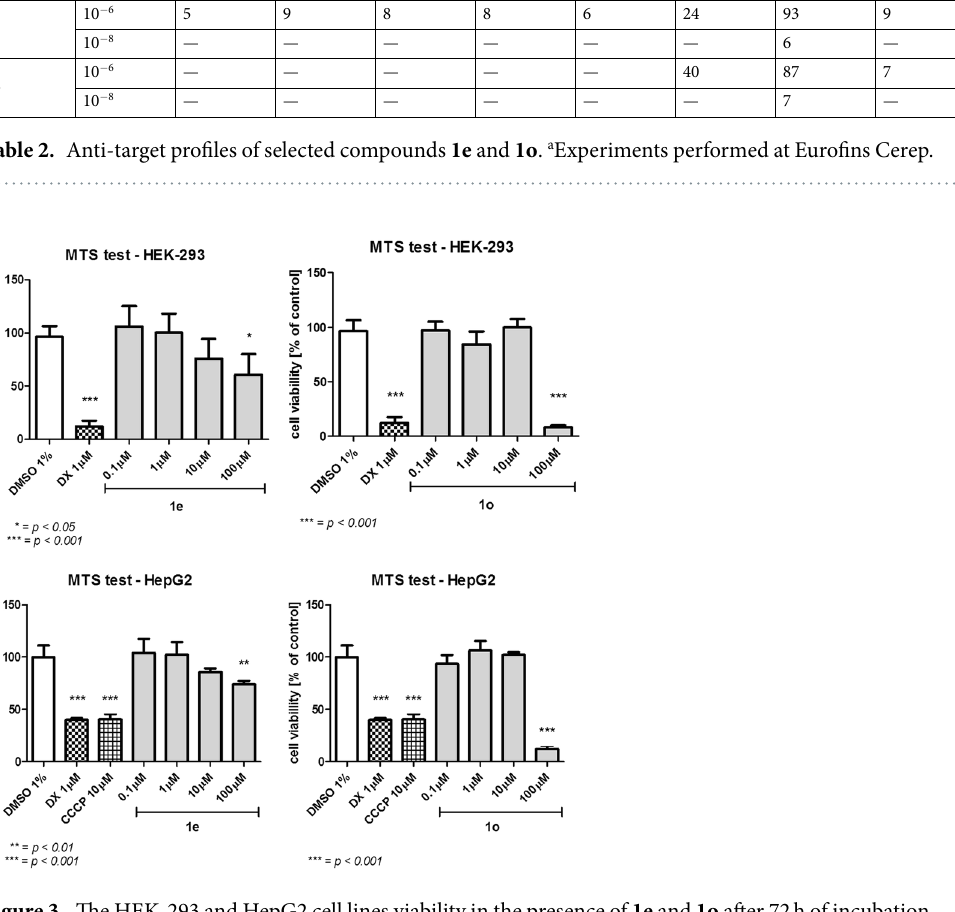
Figure 3. The HEK-293 and HepG2 cell lines viability in the presence of 1e and 1o after 72 h of